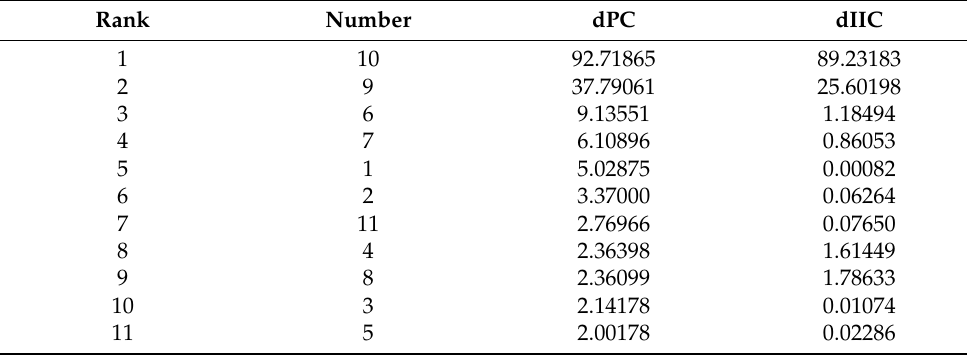
Table 6. Ranking of the core area based on landscape connectivity.